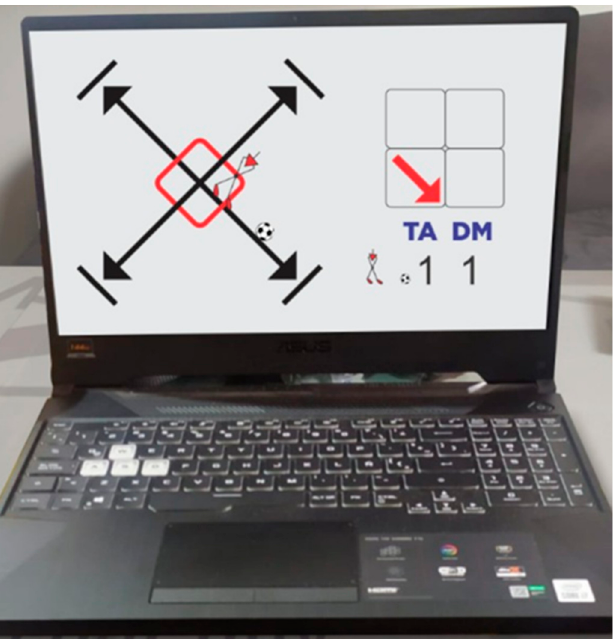
Figure 10. Screen with the stimuli and the player for the collection of information. Each filmed test